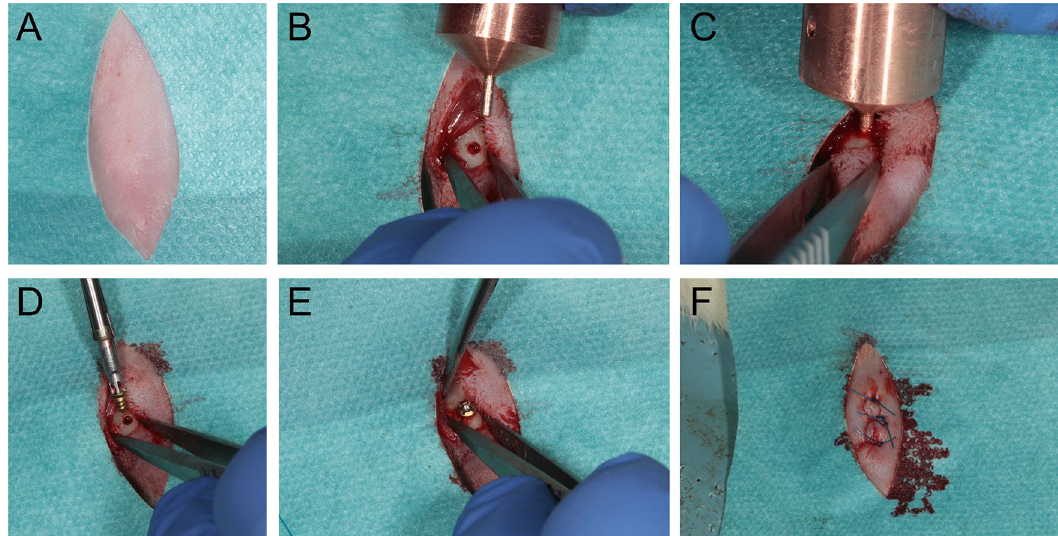
Figure 1. ( A ) Before surgery the skin was shaved, disinfected, and cut with a scalpel after sterile draping. Implantation was performed after exposure of the tibia by predrilling with a pilot drill with a 1.5 mm diameter under strict cooling with sterile saline (Medartis AG, Basel, Switzerland). In the case of the test group, the thermal treatment took place after predrilling and before implant placement. The device exhibited a congruent clamp fit in the drill studs. After a primary stable insertion of the implants, the wounds were closed with suture material and a follow-up of 7 days was performed. ( B , C ) Implantation was performed after exposure of the tibia by predrilling with a pilot drill. In the case of the test group, the thermal treatment took place after predrilling and before implant placement. ( D , E ) Primary stable insertion of the implants was achieved in all cases. ( F ) The wounds were closed with suture material and a follow-up of 7 days was